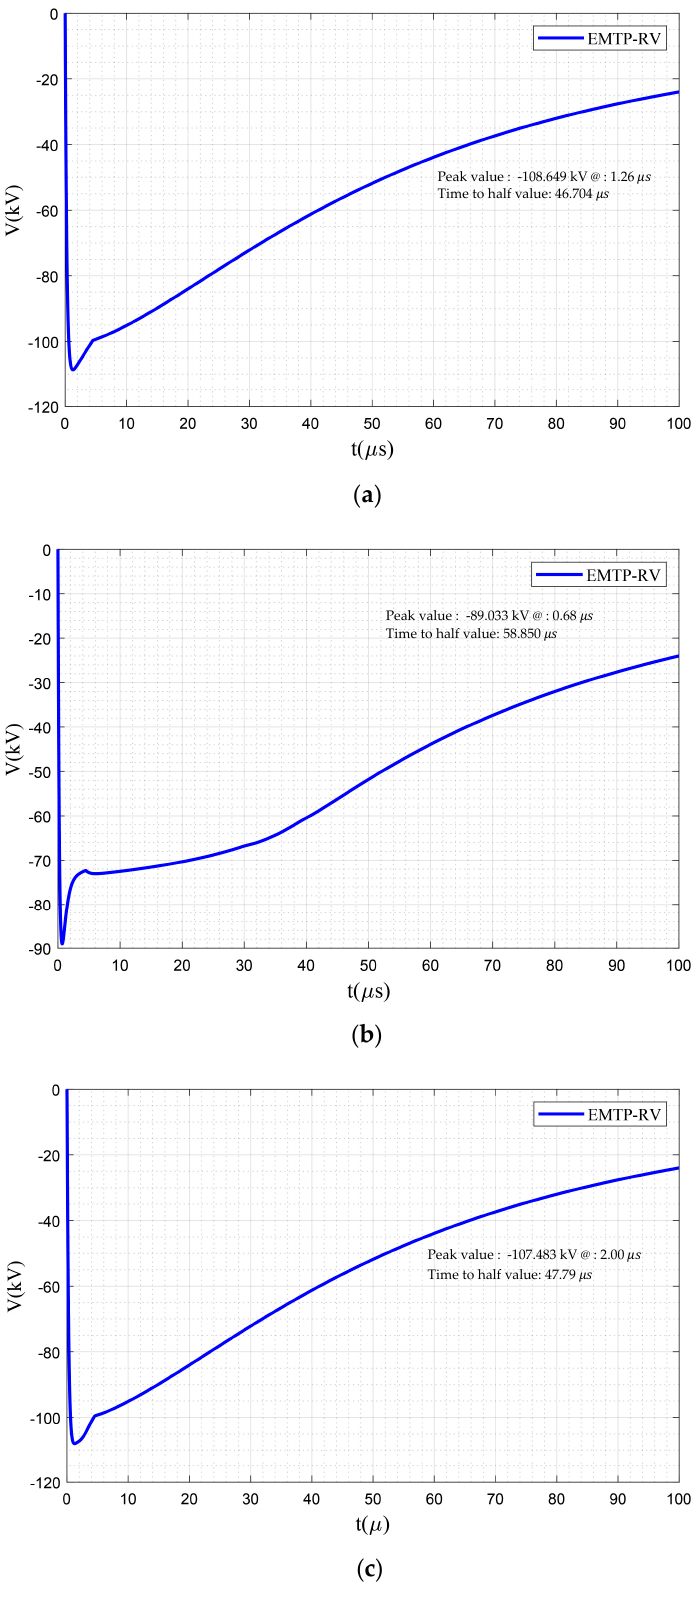
Figure 23. Applied impulse 110 kV in the presence of the ( a ) spark gap, ( b ) surge arrester, and ( c ) filtered spark gap.